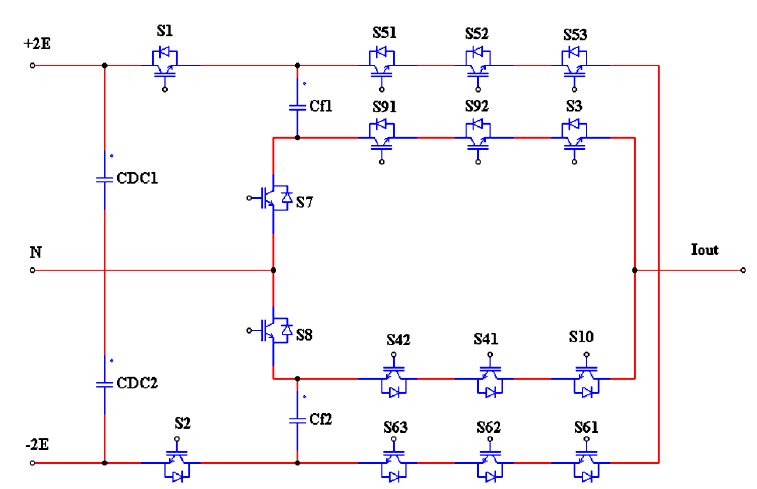
Figure 16. Circuit of hybrid cell technology for MLI.